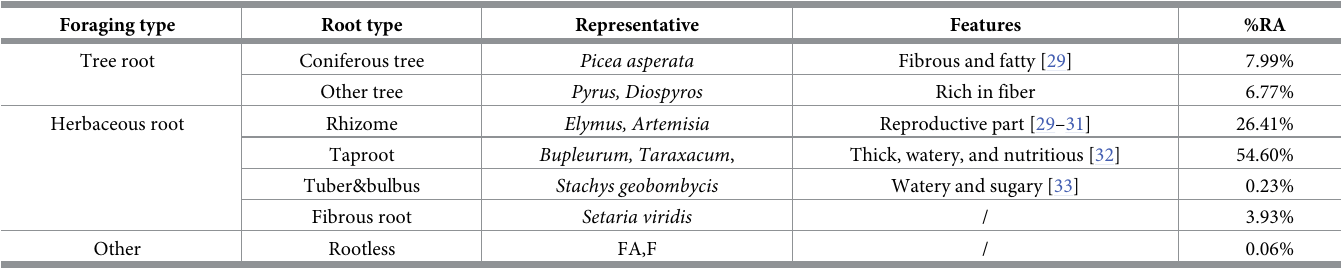
Table 4. Analysis of the feeding parts of plants. Foraging